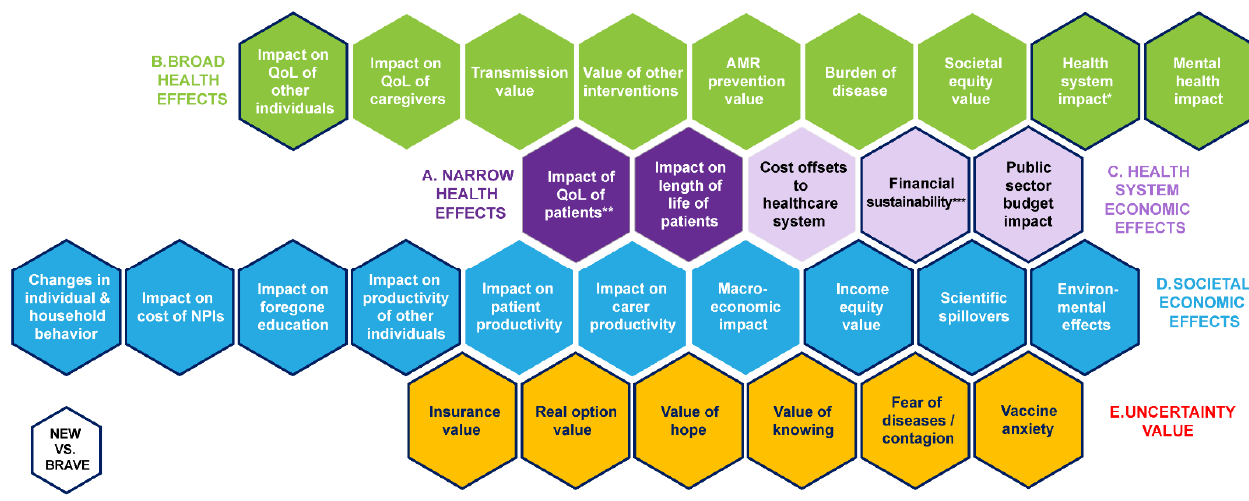
Figure 3. Visualised Vaccine Value Framework.